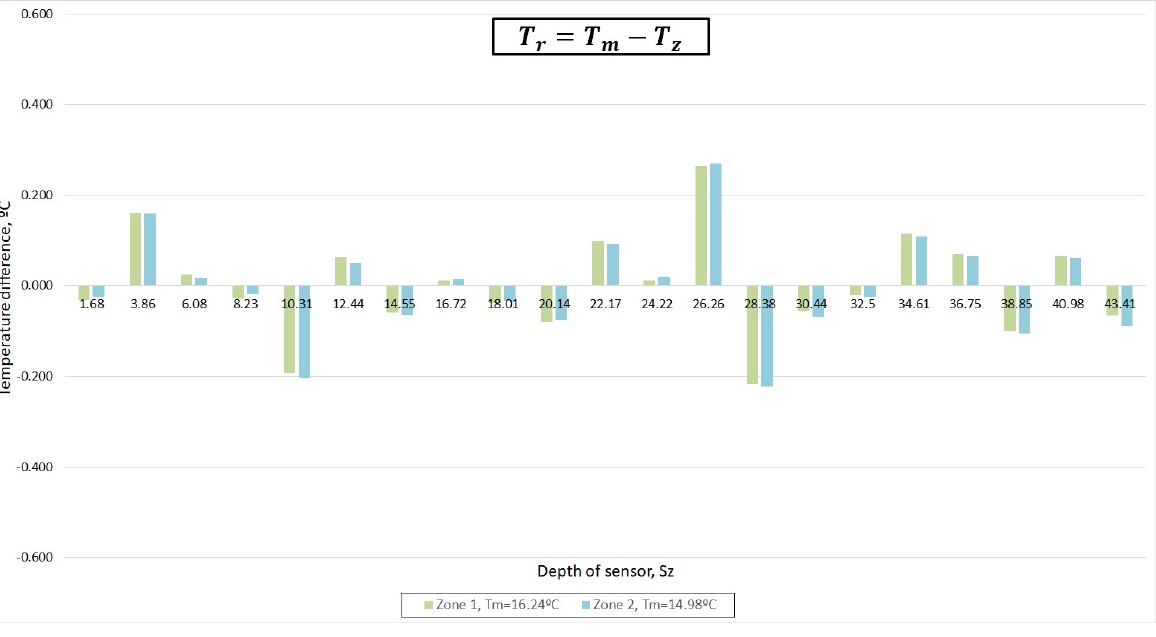
Figure 23. Measured temperature deviation of each one of the 21 sensors of 1-wire with respect to the mean temperature in zones 1 and 2.